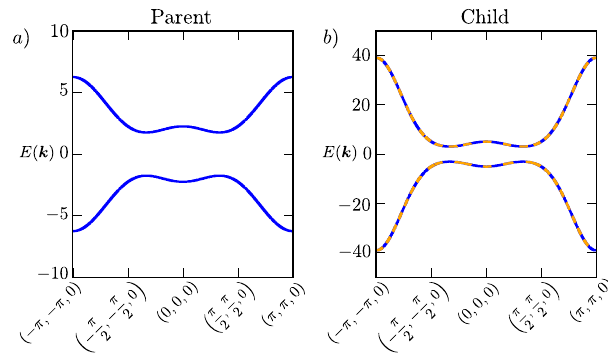
Fig. 2 Comparison of parent bulk dispersion with child bulk dispersion. Bulk spectrum along a high-symmetry line for the Hopf insulator Hamiltonian, shown in a for m = 1.5 as blue lines, and for the multiplicative Hopf insulator Hamiltonian, shown in b , for m = 1.5. The dashed blue and orange bands of the spectrum in b are doubly